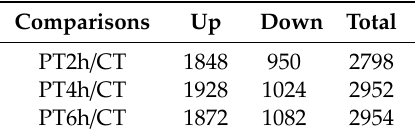
Table 2. Variation trend of gene expression quantities of differentially expressed genes (DEGs) in different comparisons.